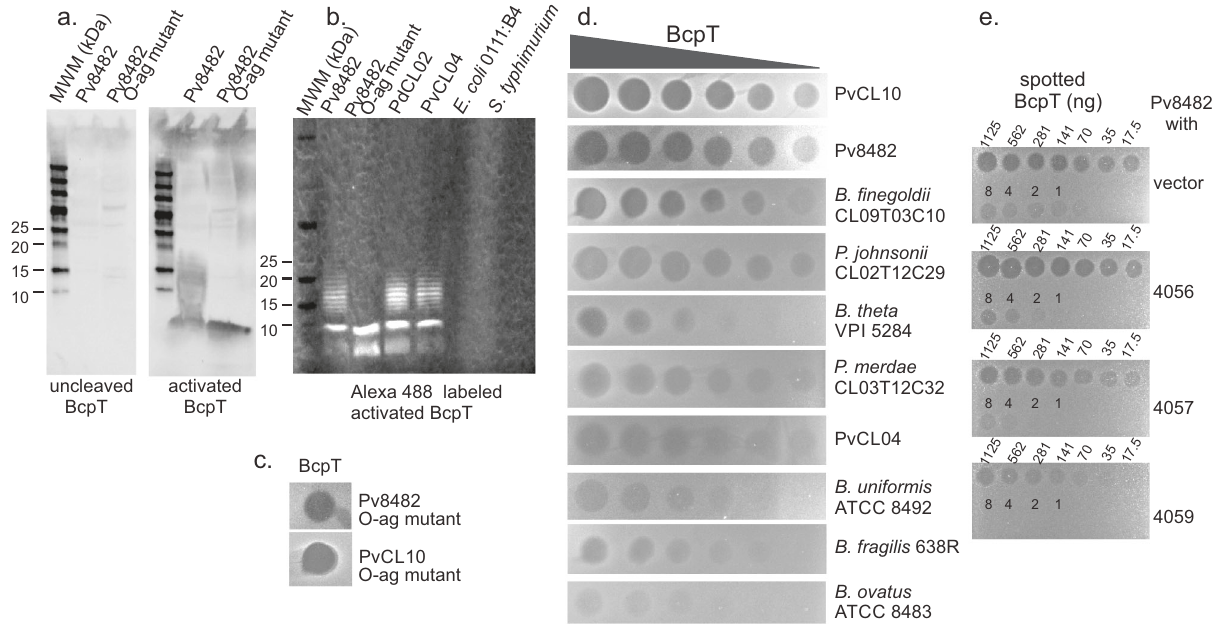
Fig. 5 Identi fi cation of BcpT receptor. a Blots of membranes of Pv8482 WT and O-antigen mutant probed with unactivated or activated BcpT and detected with af fi nity-puri fi ed α -BcpT. b Blot of puri fi ed LPS from the indicated strains probed with Alexa 488 labeled activated BcpT. c Overlay assays of O-antigen mutants of PvCL10 and Bv8482 to puri fi ed BcpT. d Agar overlay assays showing the sensitivity of various Bacteroidales species and strains to BcpT. The left most spot of each overlay is 1 µ g of toxin and each subsequent spot is a two-fold dilution. e Agar spot overlay assays showing the ability of each of three pBCPT genes to protect PvCL10 from BcpT toxicity when expressed in trans. Overlay assays were performed twice and receptor probing blots were performed twice with consistent results. Source data are provided as a Source Data fi